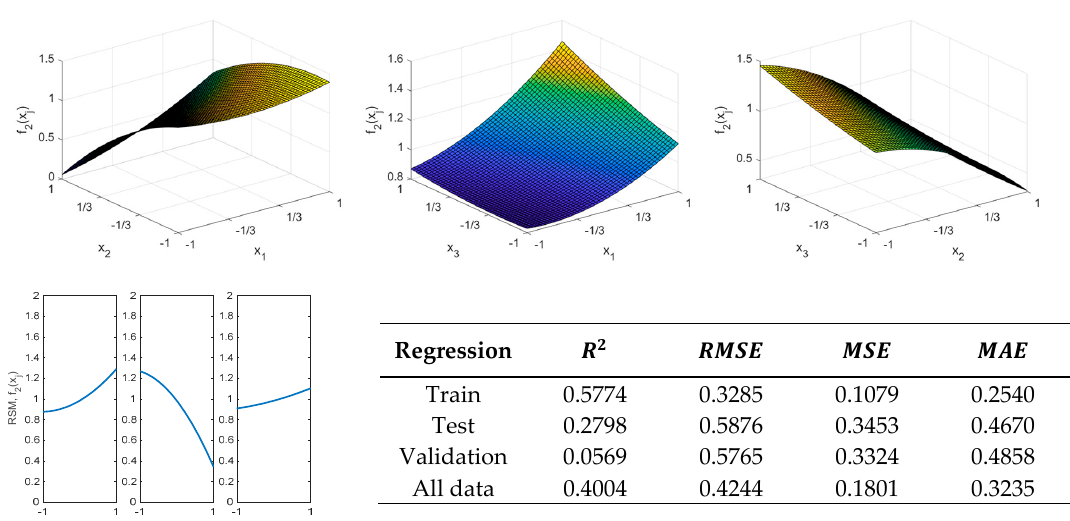
Figure 6. Response surfaces obtained, main effects plot and results of the validation metrics obtained with the RSM model for the case of type 2 function ( f 2 ).